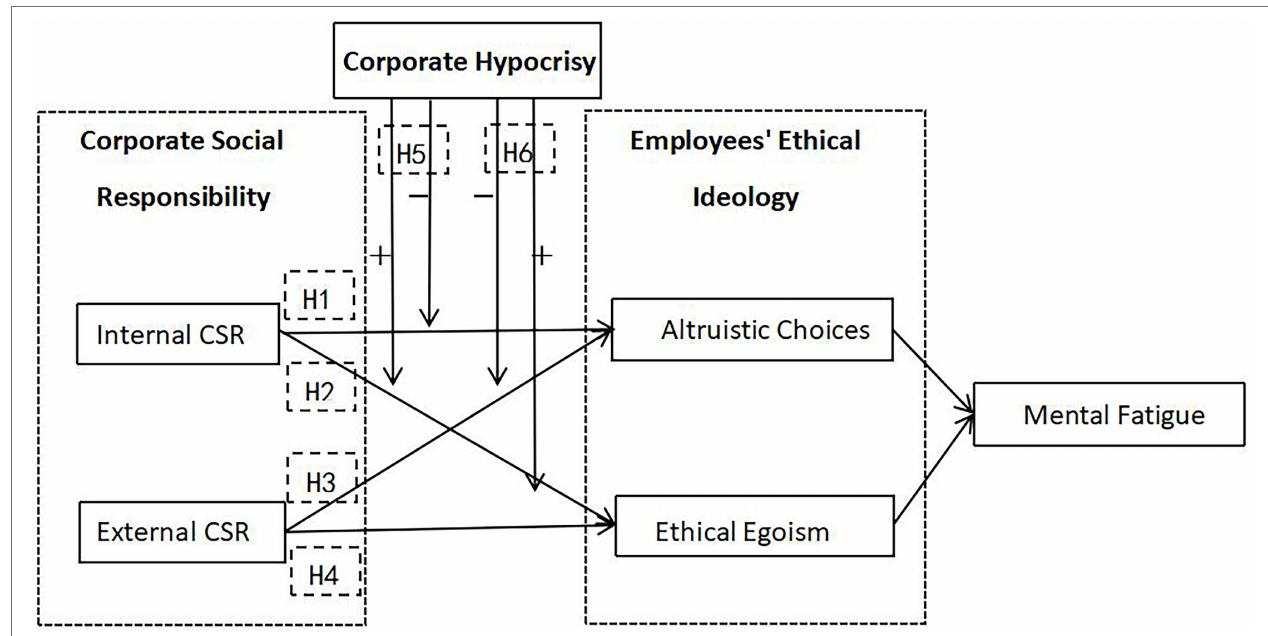
FIGURE 1 | Theoretical